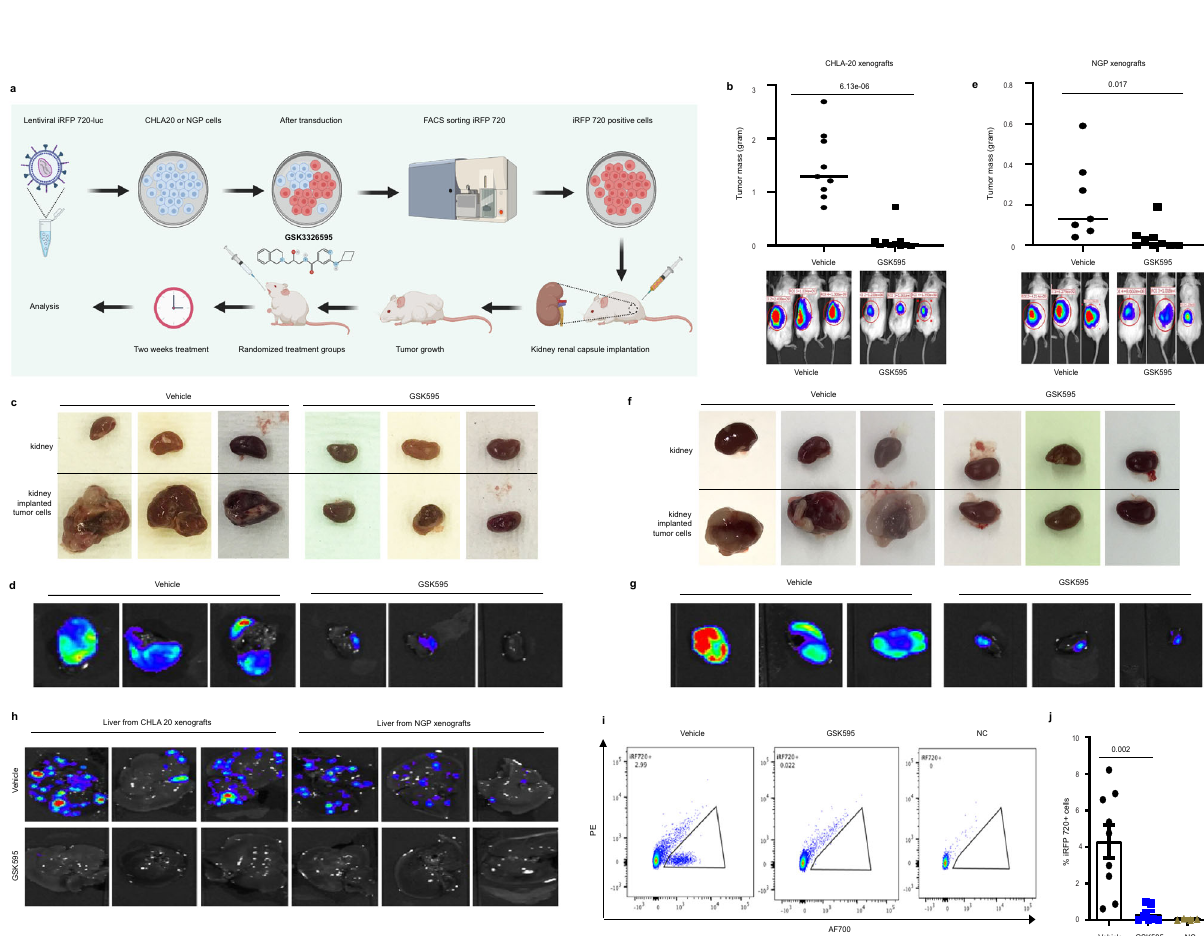
Fig. 1 Overexpression of PRMT5 is associated with high-risk neuroblastoma and poor patient survival and is required for neuroblastoma cell proliferation in vitro. a The RNA expression of PRMT5 in increasing grades of neuroblastoma from the GSE49711 RNA-seq data series (Stage 1, n = 122, Stage 2, n = 91, Stage 3, n = 64, Stage 4, n = 184). Kruskal – Wallis with Dunn ’ s multiple comparisons test was used to determine p values, which were corrected with the Benjamini – Hochberg method.). b – d PRMT5 expression levels (left) and patient survival probability (right) in stage 3 and stage 4 neuroblastoma patients in Kocak ( b , Stage 3, n = 91, Stage 4, n = 214), SEQC ( c , Stage 3, n = 63, Stage 4, n = 183), and Versteeg ( d , Stage 3, n = 13, Stage 4, n = 40) databases. P values were calculated with a two-sided Wilcoxon rank-sum test for boxplots (left) and p values were calculated with a log-rank test for survival curves (right). a – d Boxplot center represents mean, the box represents SD, and whiskers represent minimum and maximum. e The ef fi cacy of PRMT5 small molecule inhibitor GSK3203591 (GSK591) was determined by MTS assay in CHLA20, NGP, and SK-N-BE (2) cells ( n = 3). The IC50 value was determined by nonlinear regression (curve fi t) using log 10 (inhibitor) versus response (three parameters) model in GraphPad Prism. f Cell viability was measured by MTS assay in a scramble or shRNA targeting PRMT5 in NGP (left) and SK-N-BE (2) cells (right) ( n = 4). g Cleaved caspase-3 levels in neuroblastoma cell lines treated with increasing doses of GSK591. h Hoechst 33342 staining in cells treated with DMSO or 100 nM GSK591. Scale bars, 100 μ m. i Apoptosis was measured by caspase-3/7 staining in CHLA20 cells treated with DMSO or GSK591. j Quanti fi cation of caspase-3/7 positive cells ( n = 6). f , j p values were indicated by a two-tailed unpaired Student ’ s t -test using Microsoft Excel; error bars represent SD ( e – j ). e – i Representative results from three independent experiments. Uncropped immunoblots are provided in the Source Data fi le.